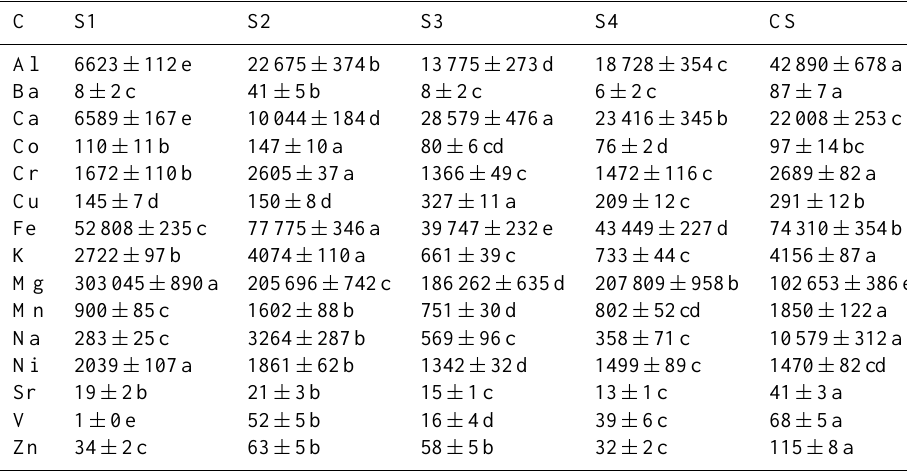
Table 3. Total content of metals (mgkg − 1 ) – mean values and standard